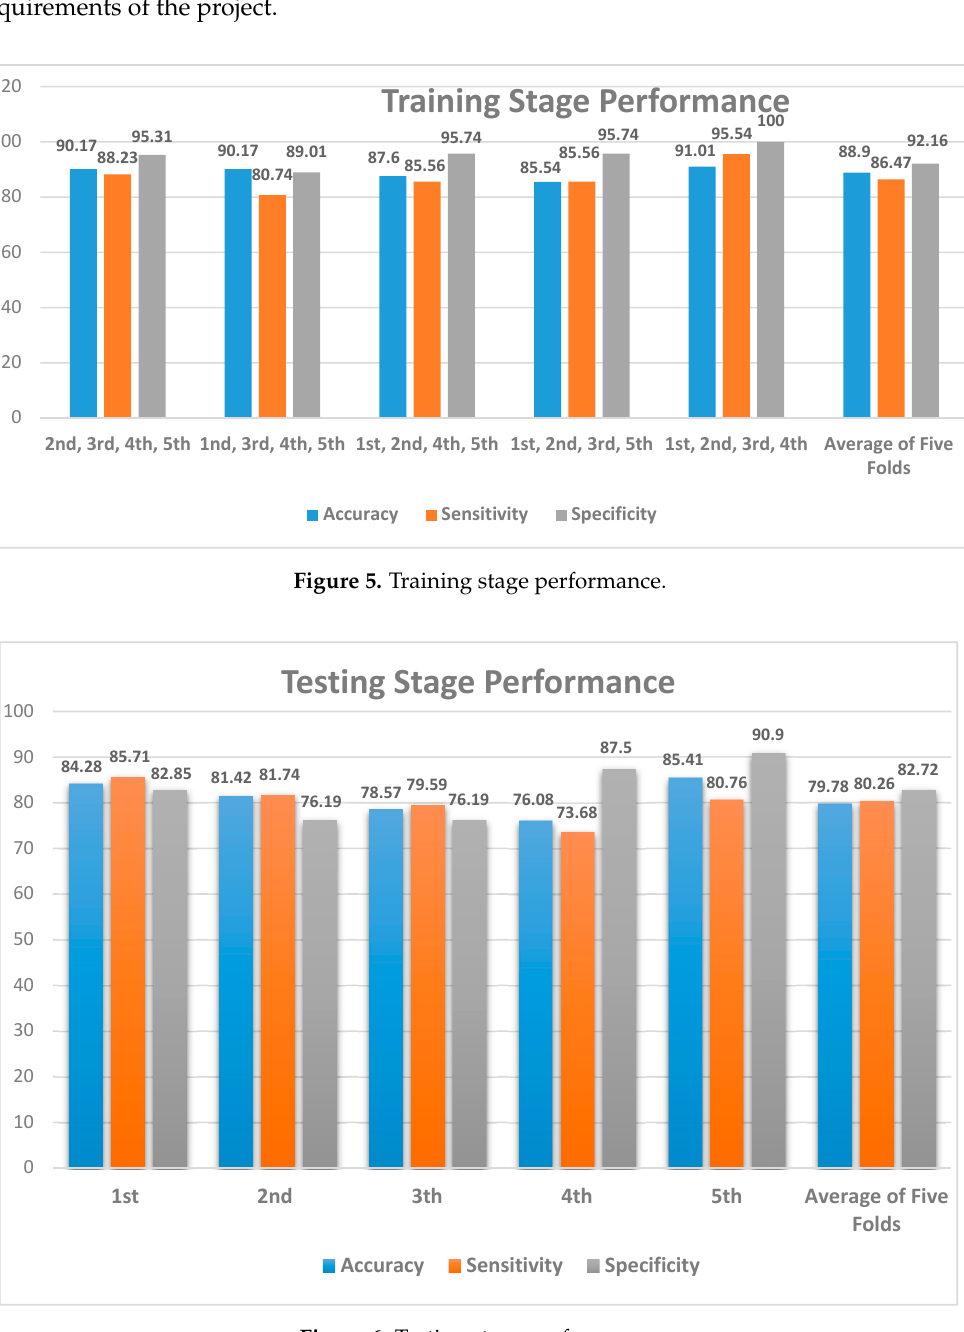
Figure 7. Performance comparison of MLP and MLP with graph cut. 5. Conclusions and Future Work For autonomous and non-destructive fault detection in power substations, we have demonstrated the application of computer vision and machine learning to detect the problem in early stages of equipment breakdown. For this, we used the thermal images generated by an infrared camera. Therefore, our approach and contribution augments the non-destructive approach to defect analysis in electrical power equipment and shows the efficacy of the approach. We used a total of 150 thermal pictures of different electrical equipment in 10 different substations in operating conditions, using 300 different hotspots and using a total of eleven features. These features are first-order and second-order statistical features. For detection, our approach used the MLP to classify the thermal condition of components of power substations into “defect” and “non-defect” classes, achieving an